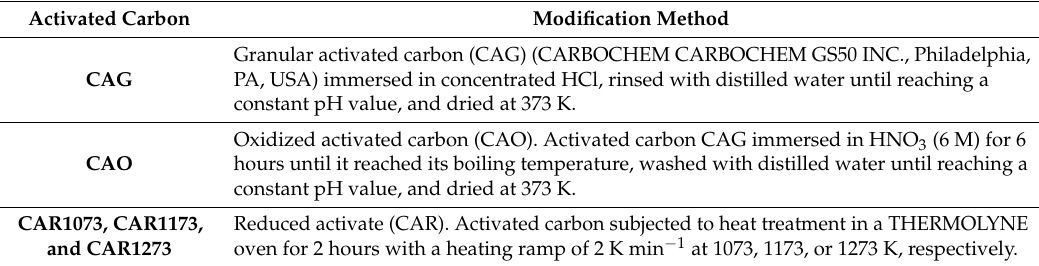
Table 2 discloses preparation methods of the activated carbons analyzed in this work. Table 2. Modifications made to carbon activated granular